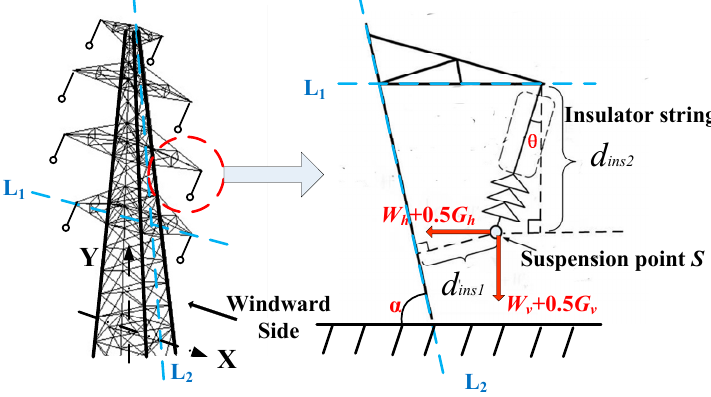
Figure 5. Rigid straight bar method diagram.